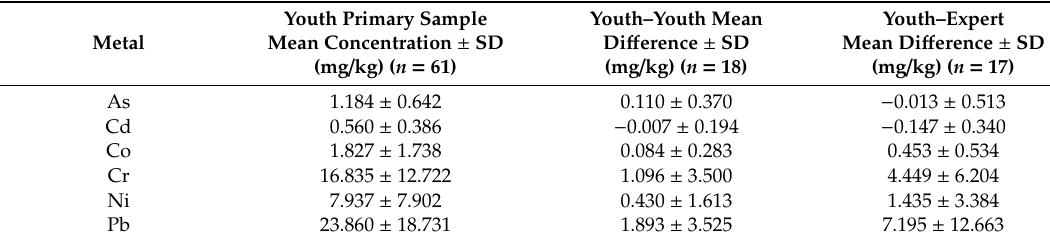
Table 3. Summary of mean metal concentration for youth primary moss samples, mean di ff erence between youth primary and replicate samples and mean di ff erence between youth primary, and expert replicate samples for each priority metal.